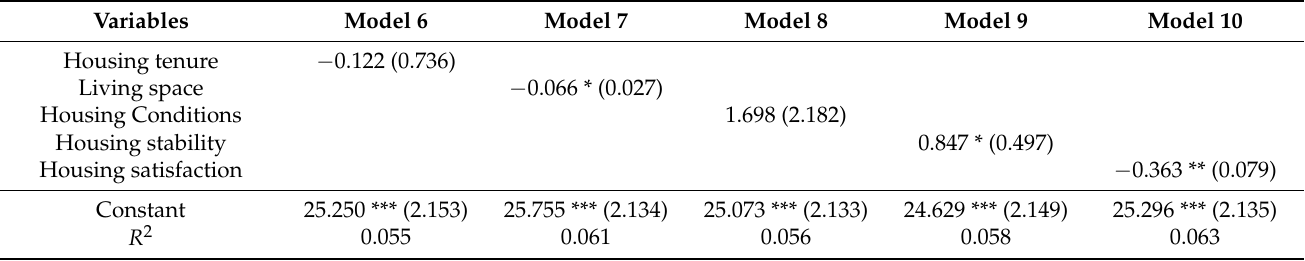
Table 4. Regression results of housing status and